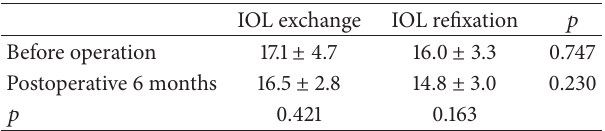
Table 5: Comparison of IOP between the IOL exchange and IOL refixation group before and after surgery. IOL